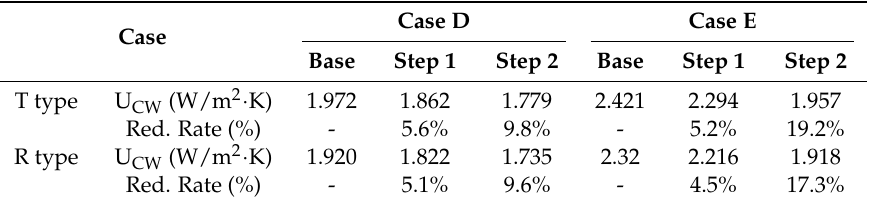
Table 6. Detailed analysis for D and E cases.